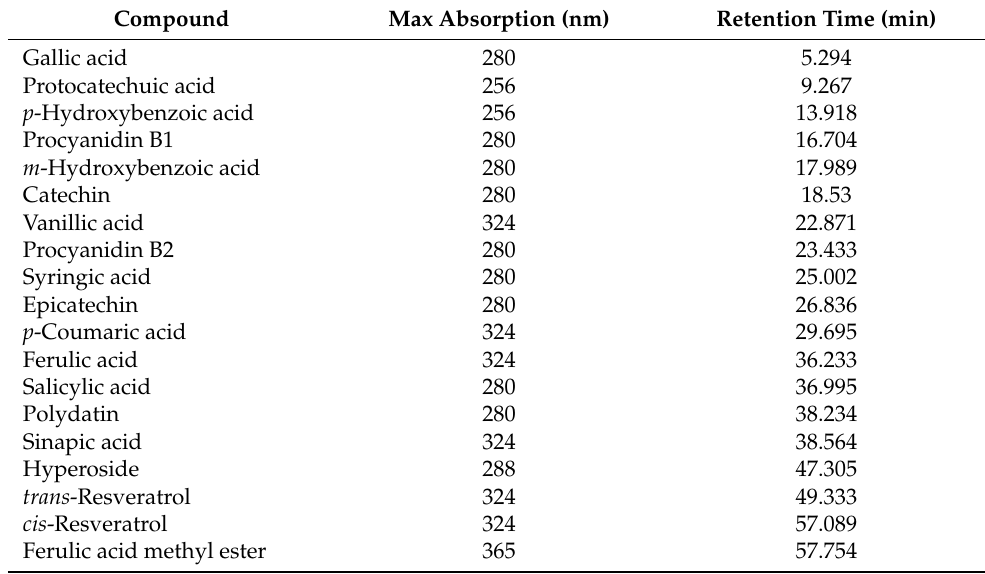
Table 1. Characteristics of polyphenol standards used in HPLC analysis and their retention times.